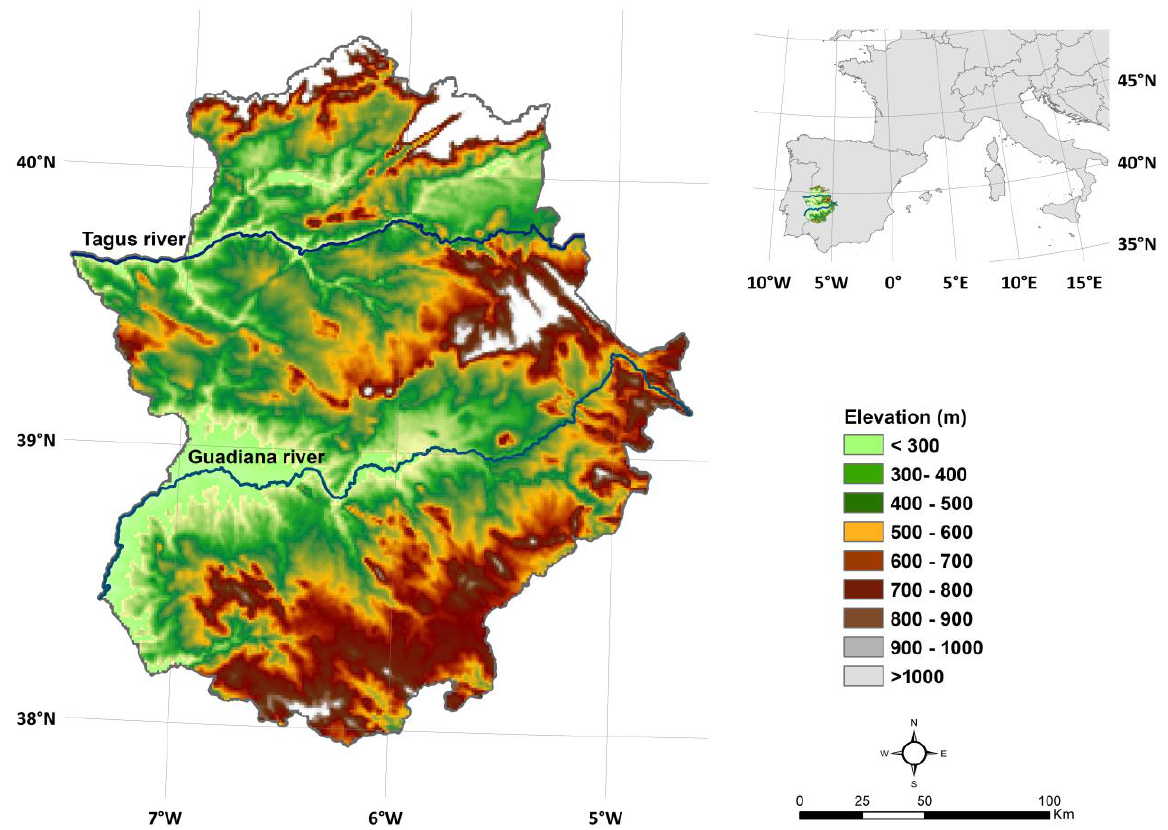
Figure 1. Digital elevation model of Extremadura.